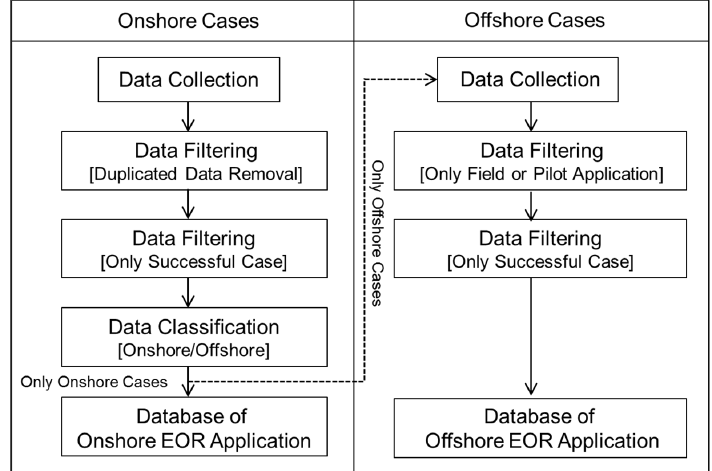
Figure 2. Procedure for data collection of EOR application cases.